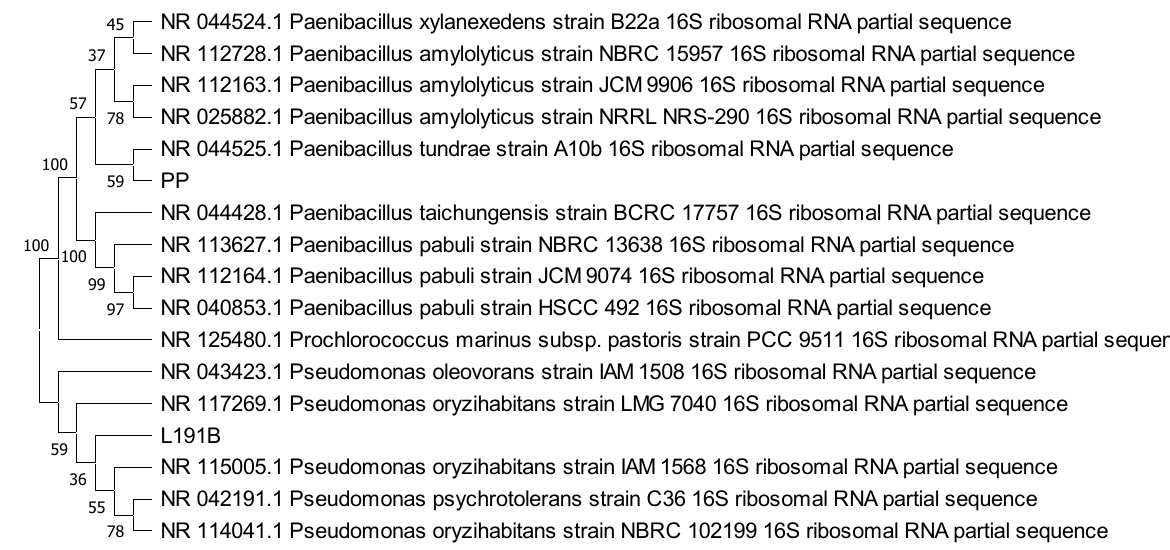
Figure 3. Fungus P. tremulae : ( a ) in a pure culture on malt nutrient medium; ( b ) with a Populus mi- croshoot post inoculation.